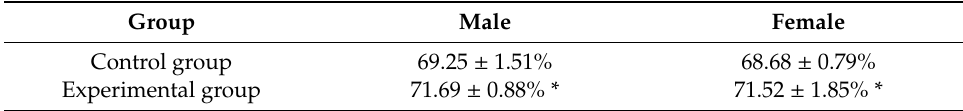
Table 1. Intergroup comparison of percentage root volume / total